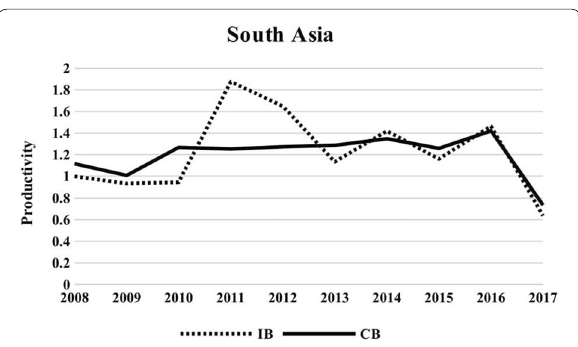
Fig. 4 Levels of productivity by years in South